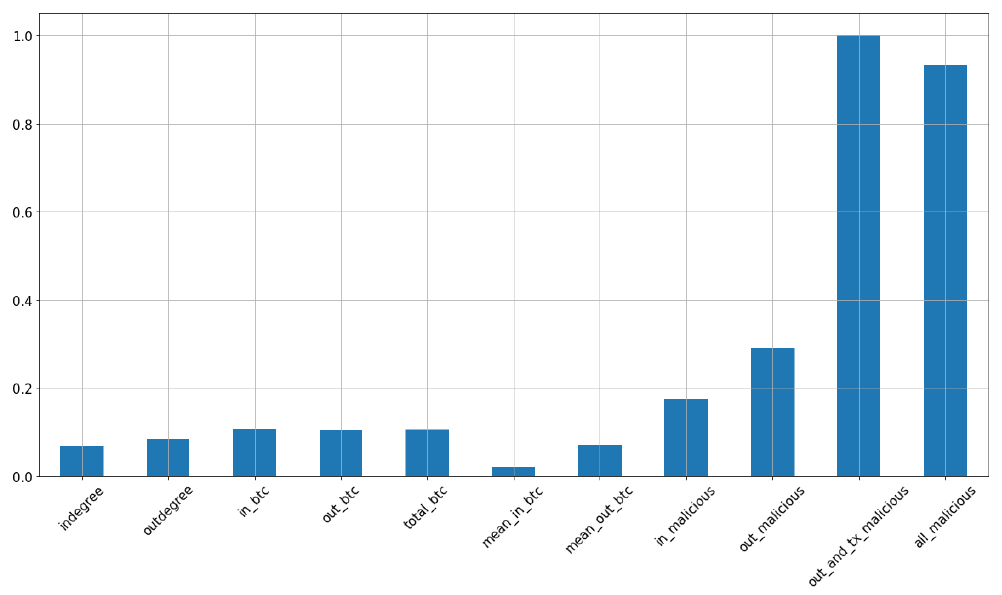
Figure 5. Correlation with class fraudulent or